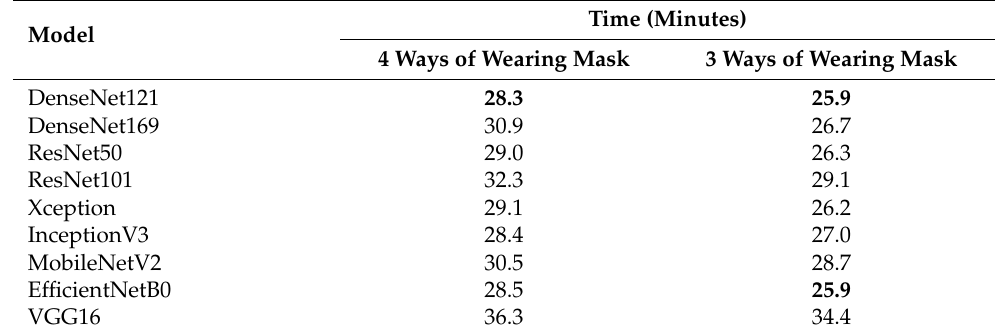
Table 4. The computational time to fit the models for gender classification over two datasets (4 ways of wearing mask, and 3 ways of wearing mask).